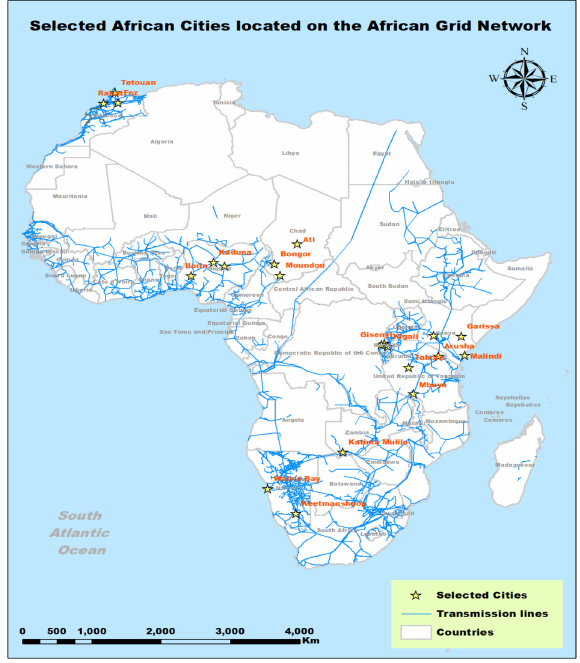
Figure 4. Selected cities on the African network grid